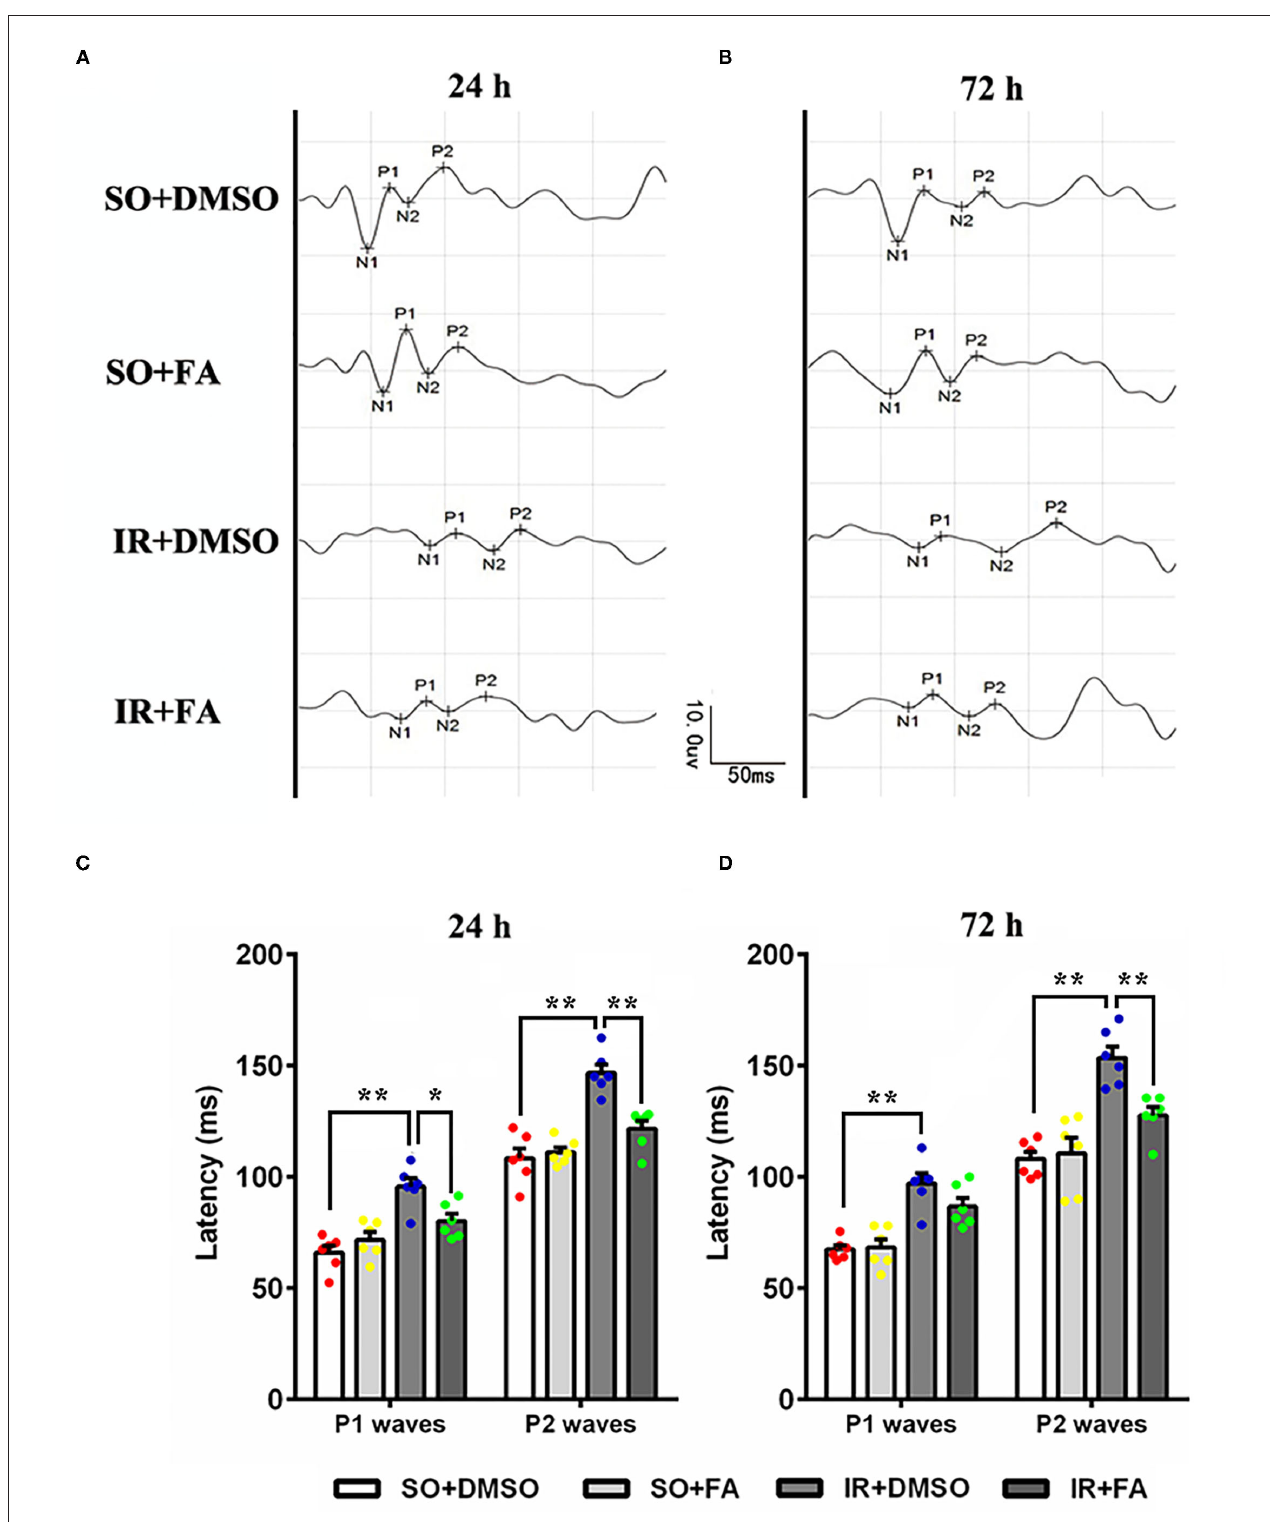
FIGURE 4 | Protective effect of PPAR α activation by FA on FVEPs in IR rats. (A) Representative images of FVEPs at 24h post-IR modeling. (B) Representative images of FVEPs at 72h post-IR modeling. (C) The latency of the first positive wave (P1 wave) and second positive wave (P2 wave) of FVEPs in rats at 24h post-IR modeling. (D) The latency of the P1 wave and P2 wave of FVEPs in rats at 72h post-IR modeling. Data are the mean ± SEM; * p < 0.05; ** p < 0.01. Scale bar = 10.0 µ V and 50ms.